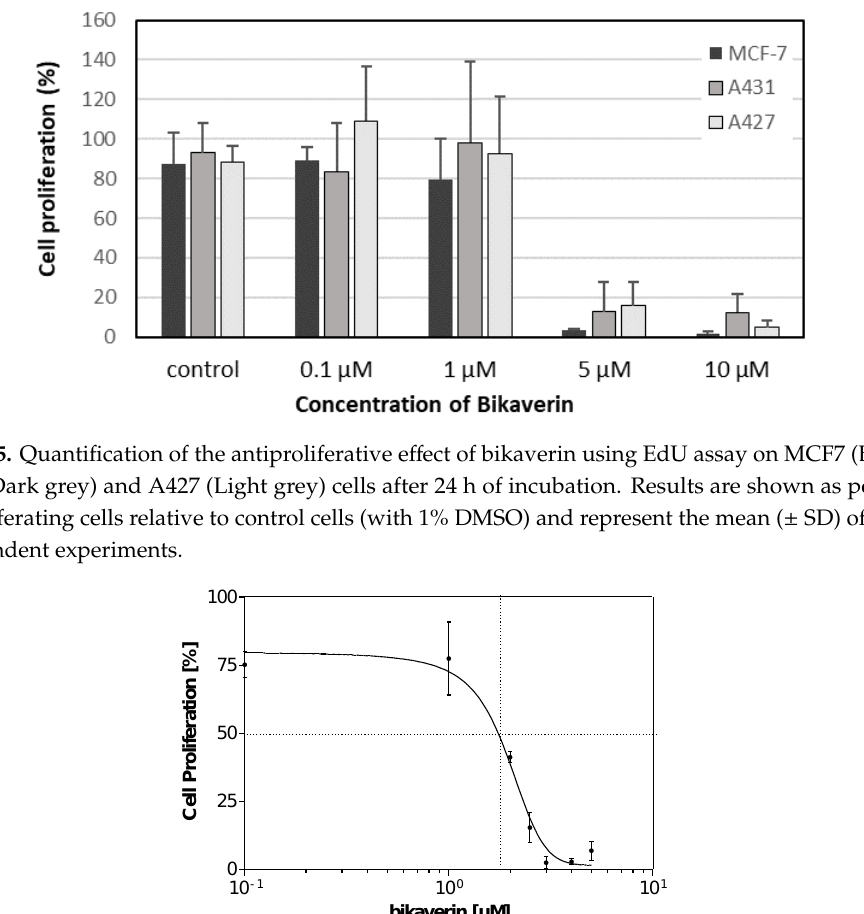
Figure 6. Dose dependent inhibition of MCF7 cell proliferation by bikaverin using EdU assay. The EC 50 is 1.97 µM, which was determined by three independent replications and mean values with corresponding standard deviations are given.